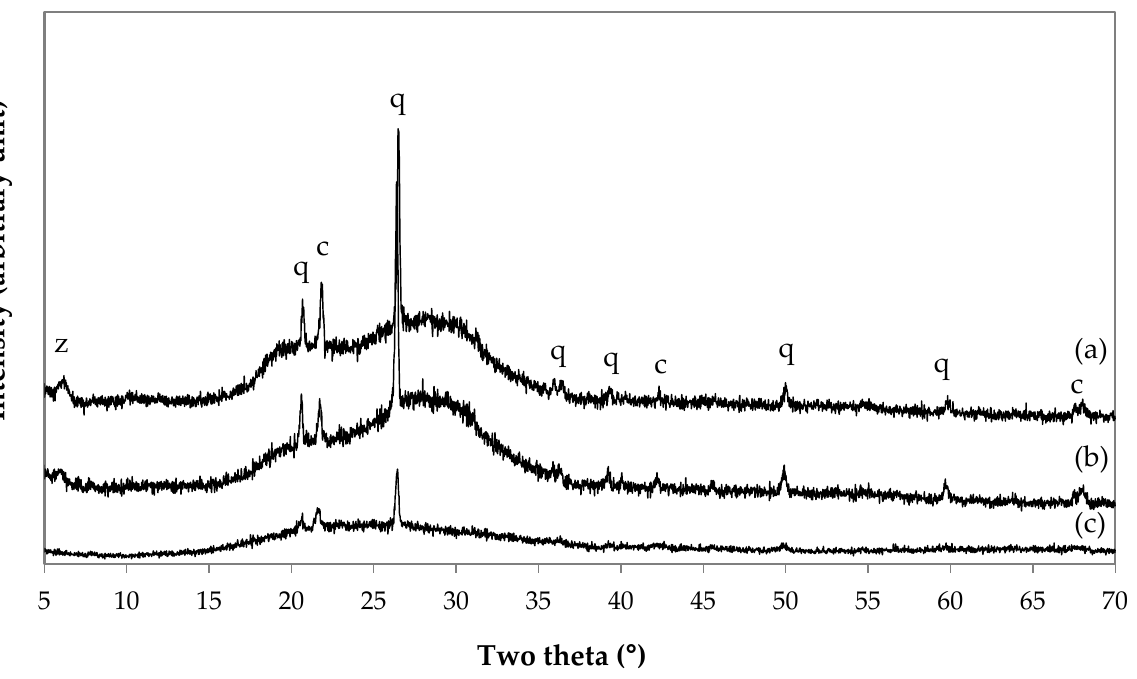
Figure 3. XRD patterns of sample S-4.5 (a) before washing, (b) after washing and (c) after firing (q: quartz PDF 33-1161, c: cristobalite PDF 39-1425 and z: zeolite PDF 01-076-6494).